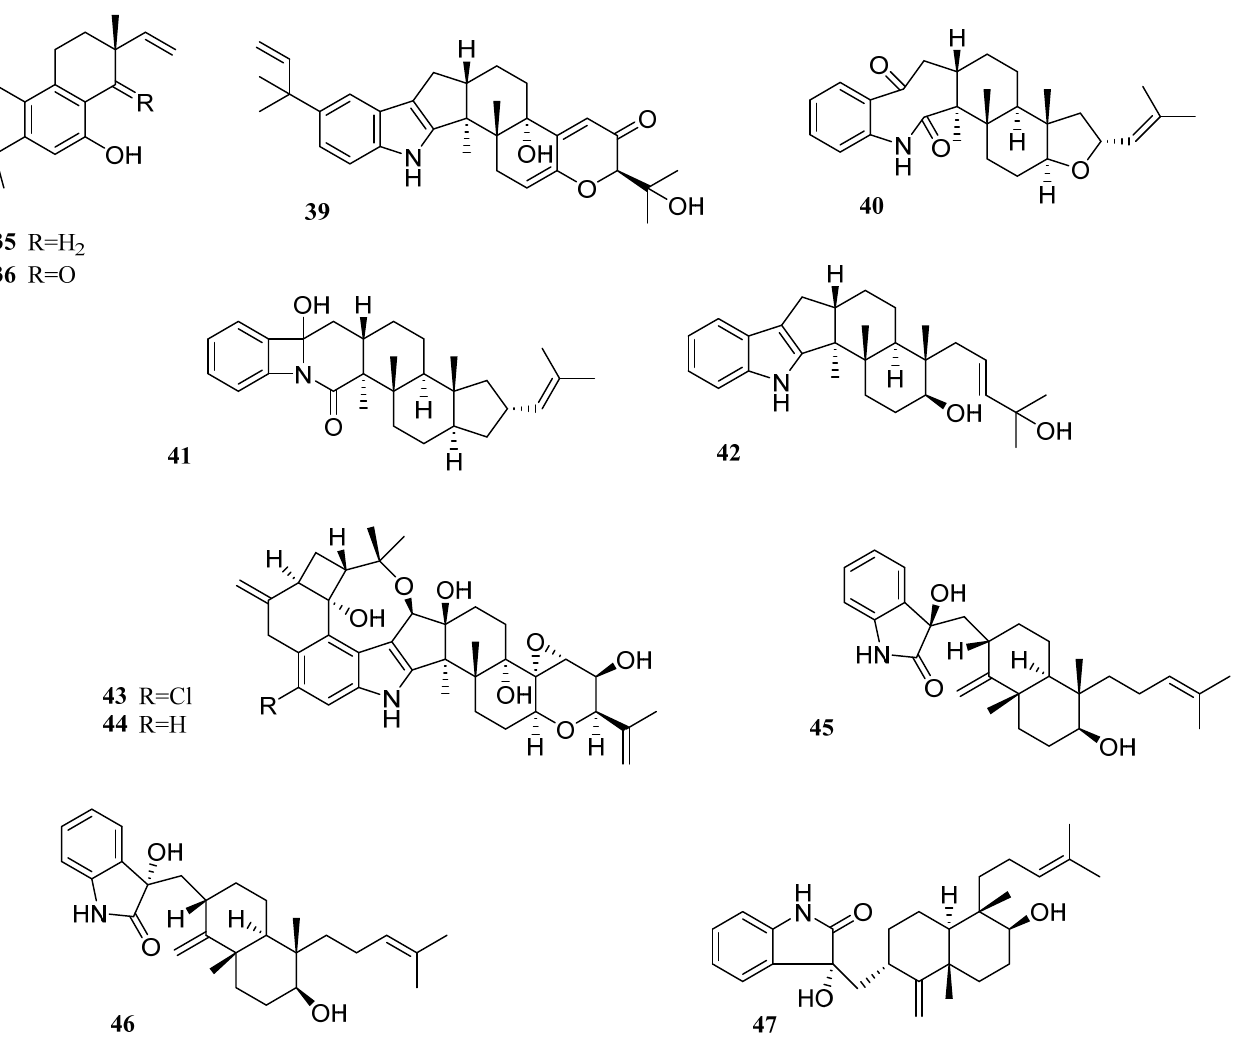
Figure 5. Chemical structures of diterpenes ( 10 – 47 from Aspergillus sp.).